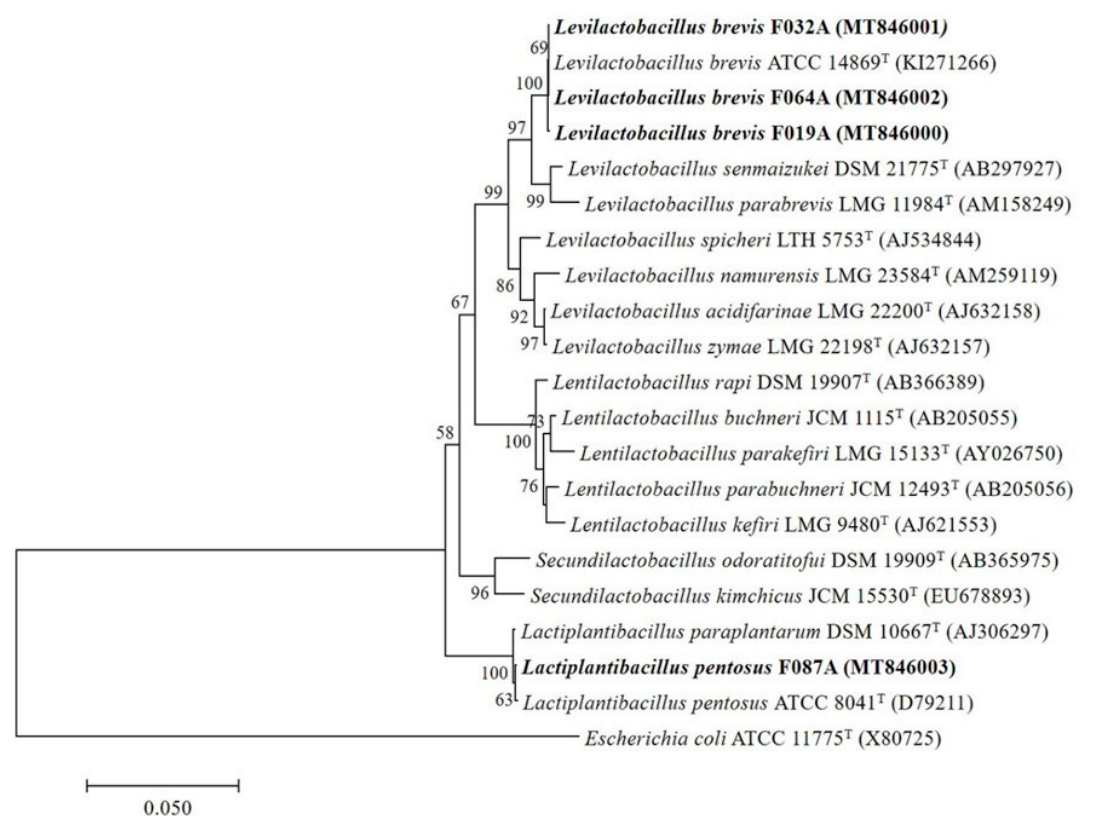
Figure 3. Phylogenetic relationships of 4 selected GABA-producing LAB isolates including F019A, F032A, F064A and F087A (bold), comparison with some species of the lactic acid bacteria based on the sequence of 16S rRNA gene using universal primer 27F and 1492R. The branching pattern was generated using the neighbor-joining method by MEGA7 software. Bootstrap values; expressed as percentage of 1000 replications, more than 50% are shown at the branch points. Scale bar, 0.050 represented substitution per nucleotide position. Escherichia coli ATCC 11775 T (X80725) is presented as out group